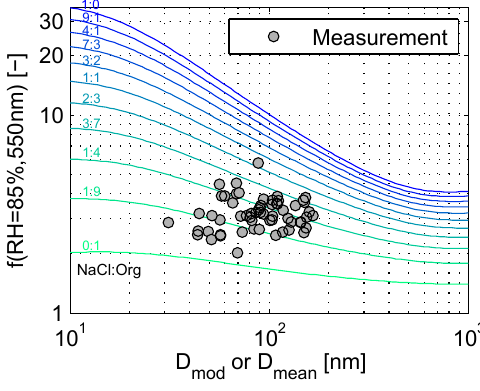
Fig. 9. Scattering enhancement f ( RH = 85%, λ = 550nm) modeled for various NaCl to organic species volume ratios (colored lines) versus the mode diameter D mod of a log-normal size distribution (with a fixed geometric standard deviation of 1.8). The grey points depict the measured values of f ( RH = 85%, λ = 550nm) versus the number mean diameter D mean measured by SMPS and OPC (daily